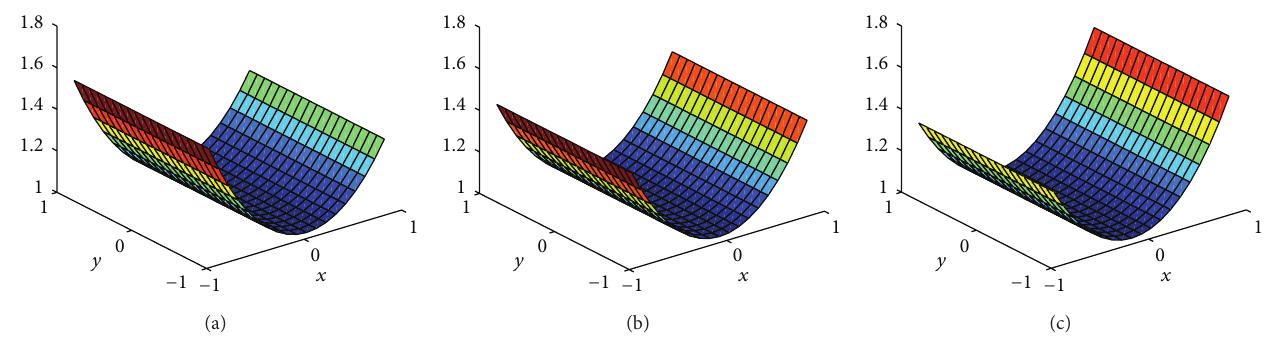
Figure 1: The solution of (DS) corresponding to V 𝑠,1 : take 𝑐 = 1 , 𝑧 0 = 0 , 𝑑 = 1/2 , 𝑘 = 0 , 𝛼 = 2 , (a) 𝑡 = −1/10 , (b) 𝑡 = 0 , and (c) 𝑡 = 1/10 .